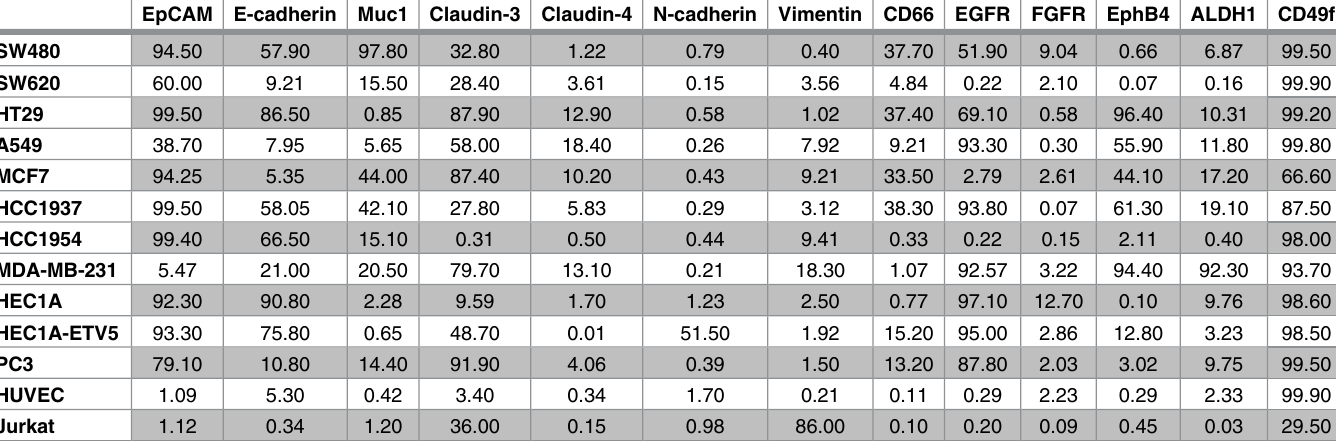
Table 1. Summary of flow cytometry analysis.